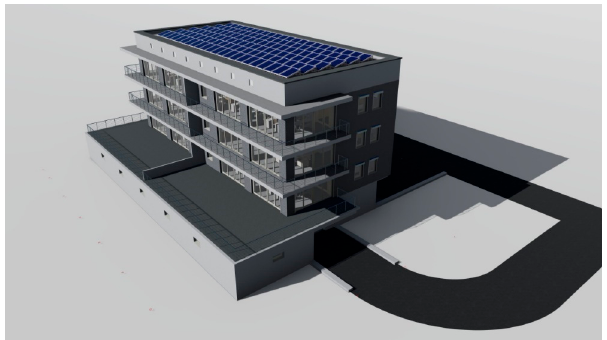
Figure 8. Model 1 of the building.